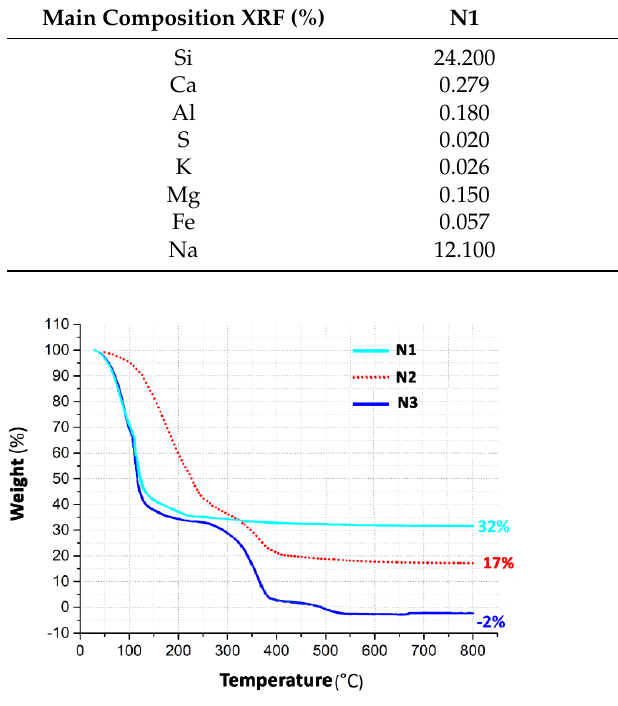
Figure 5. TGA curves of the nanomaterials.